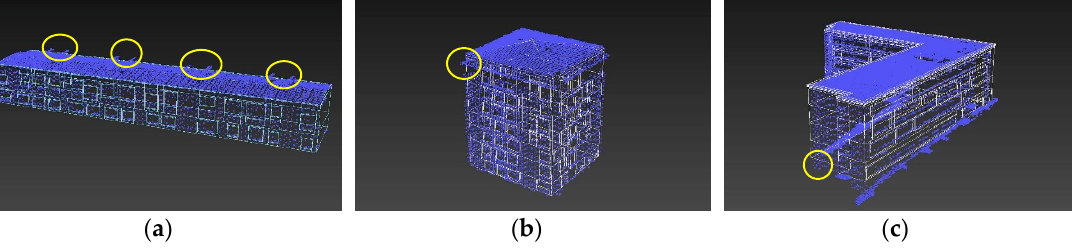
Figure 16. Model wireframes and the corresponding point clouds: ( a ) a two-storied building model with double pitched roof; ( b ) a seven-storied building with hip roof; and ( c ) a four-storied building with flat roof. Table 4. Completeness and accuracy of roof segmentation.